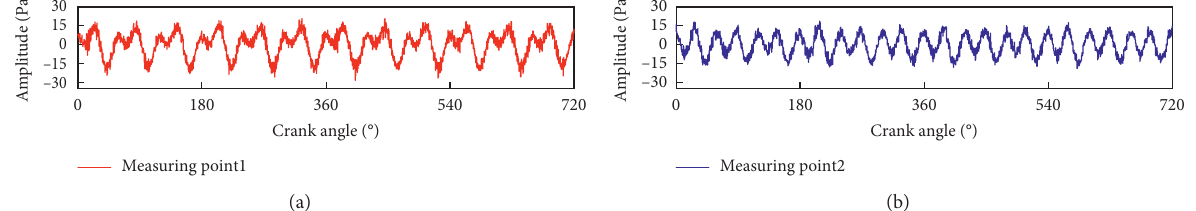
Figure 14: The measured acoustics signals of the diesel engine. (a) The sound pressure in measuring point 1. (b) The sound pressure in measuring point 2.